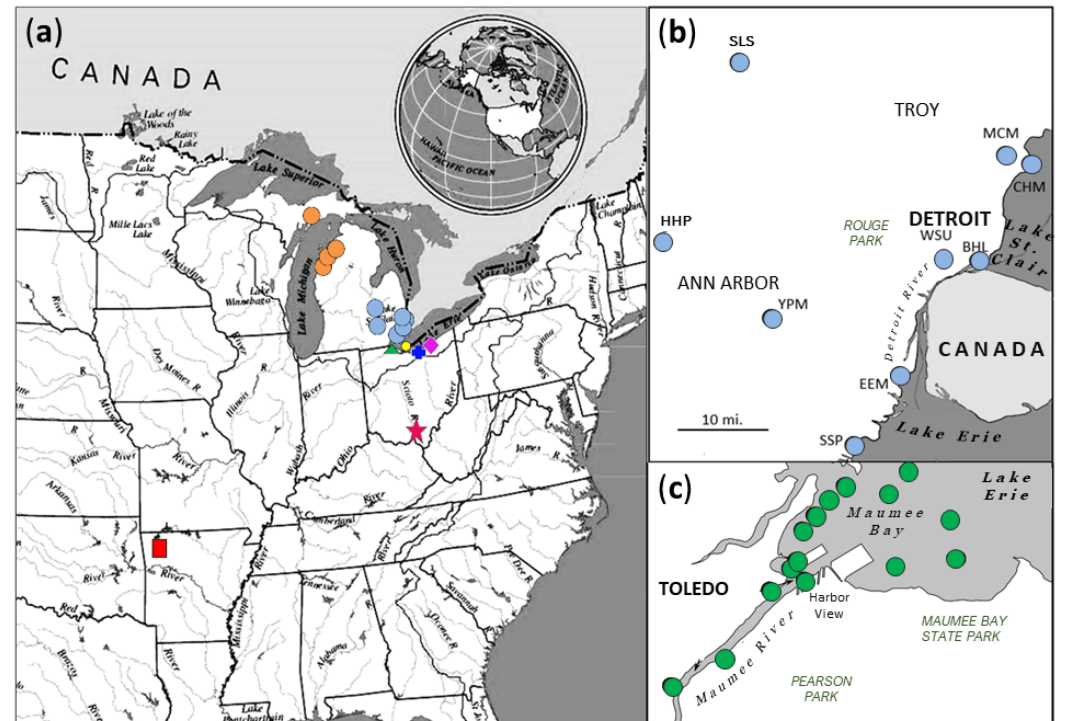
Figure 1. ( a ) Map depicting collection sites of chironomids across the Laurentian Great Lakes and North American rivers. ( b ) Inset showing detailed locations of collection sites throughout Southeastern Michigan. ( c ) Inset showing detailed locations of collection sites near Toledo Harbor, Ohio. Collection site latitudes and longitudes for the chironomids in the curated set are included in their GenBank accession annotations.